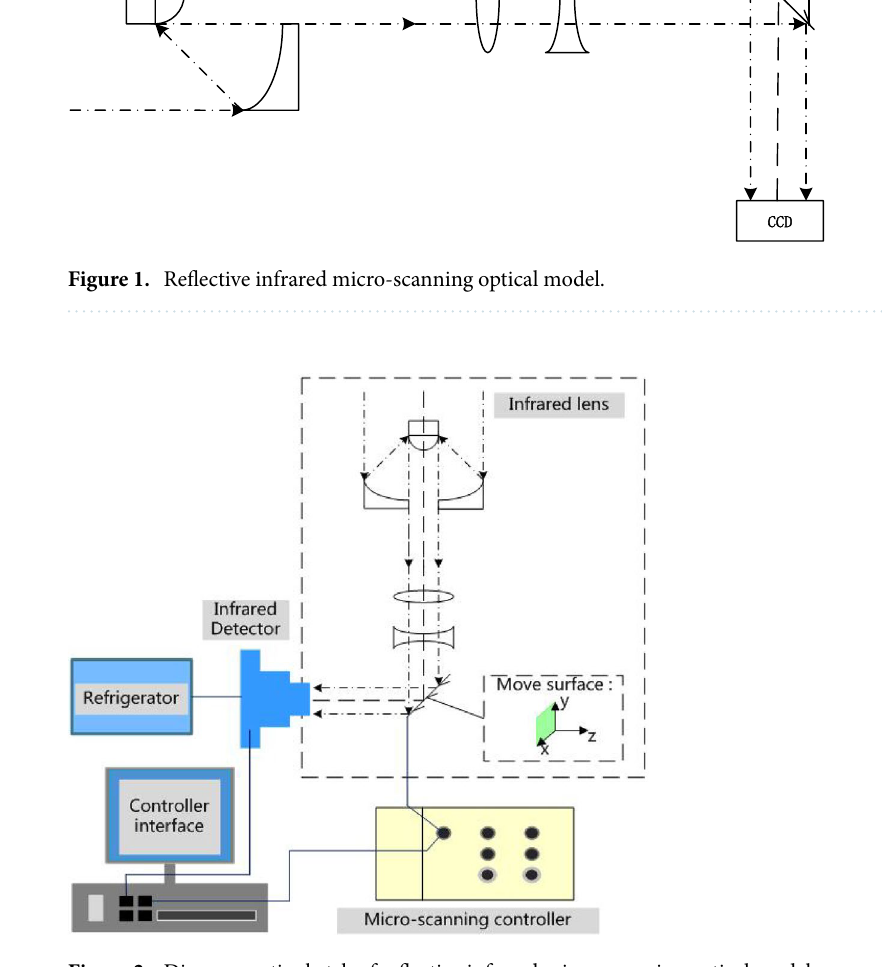
Figure 2. Diagrammatic sketch of reflective infrared micro-scanning optical